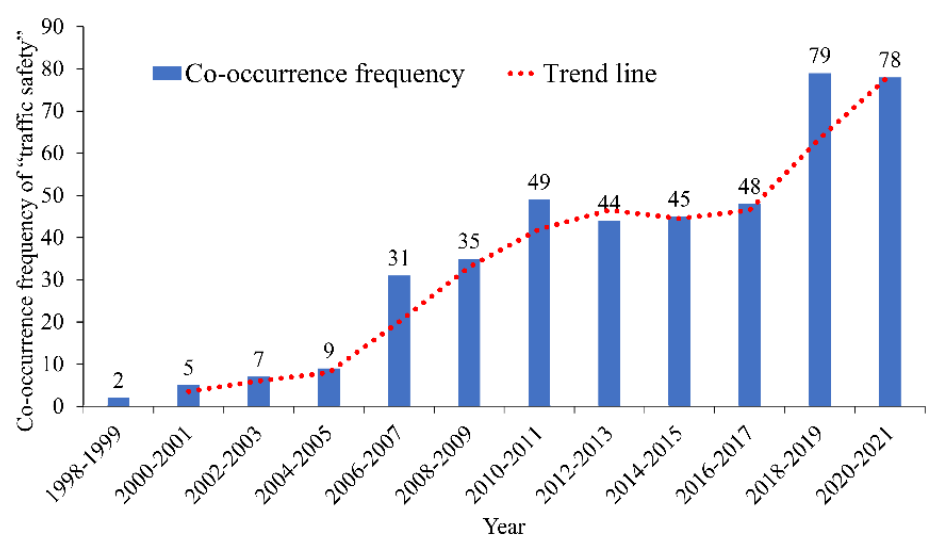
Figure 7. Co-occurrence frequency and time distribution of “traffic safety”.